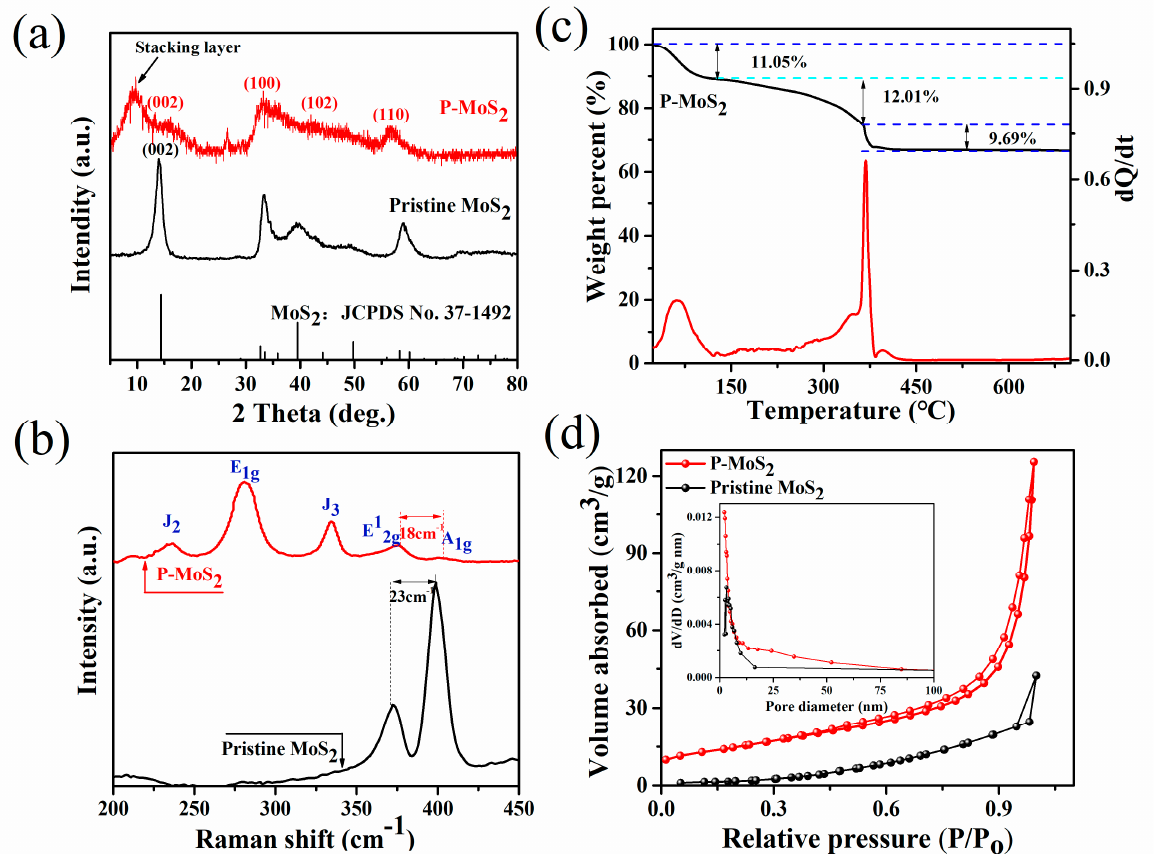
Figure 3. ( a ) XRD pa tt erns of P-MoS 2 and pristine P-MoS 2 . ( b ) Raman spectra of P-MoS 2 and pristine MoS 2. ( c ) TGA and DTA curves of P-MoS 2 . ( d ) N 2 adsorption/desorption isotherm and corresponding pore size distribution of P-MoS 2 and pristine MoS 2 .